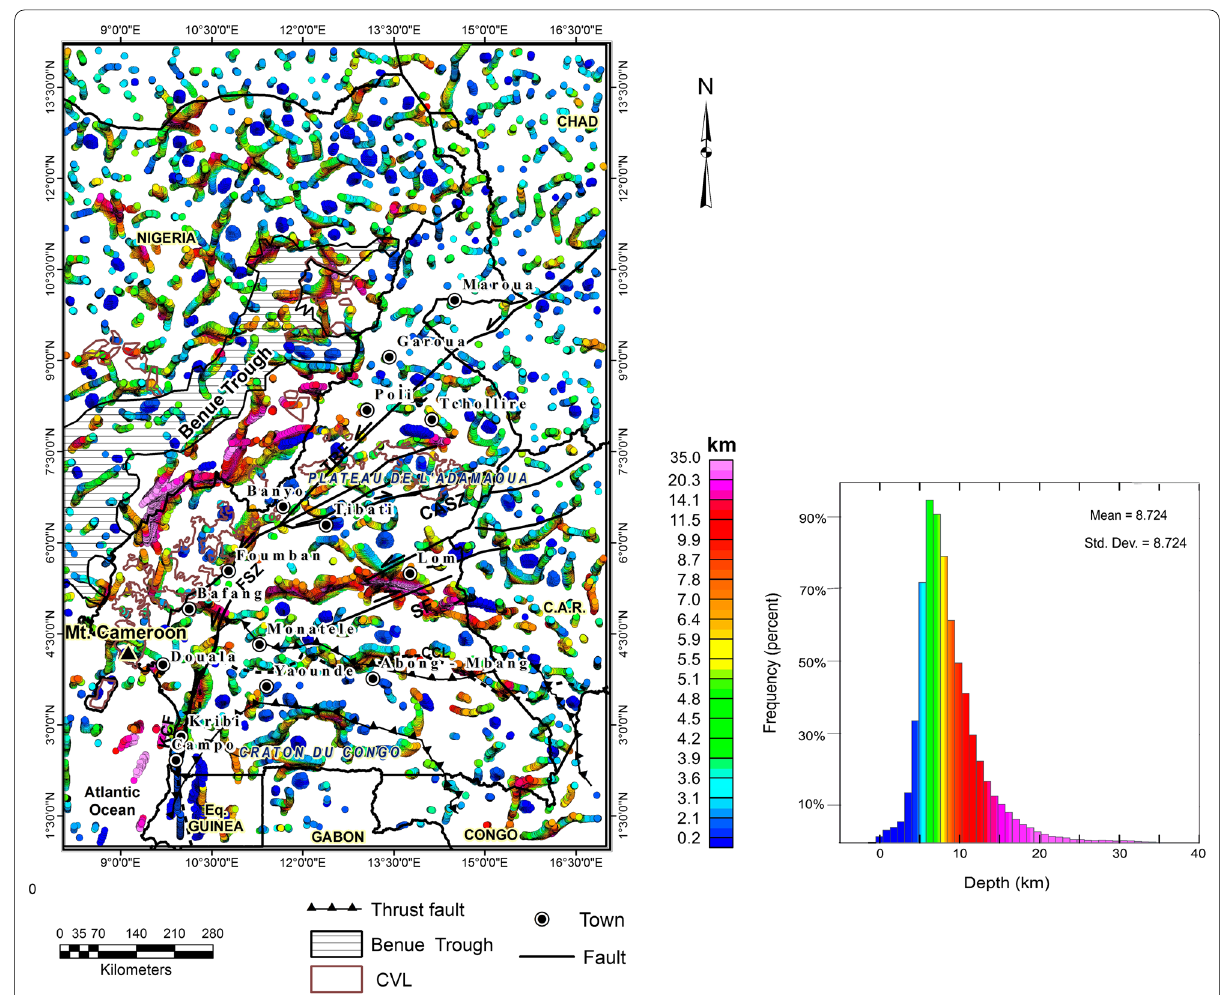
Fig. 10 Euler deconvolution map for the Land gravity data with a structural index of